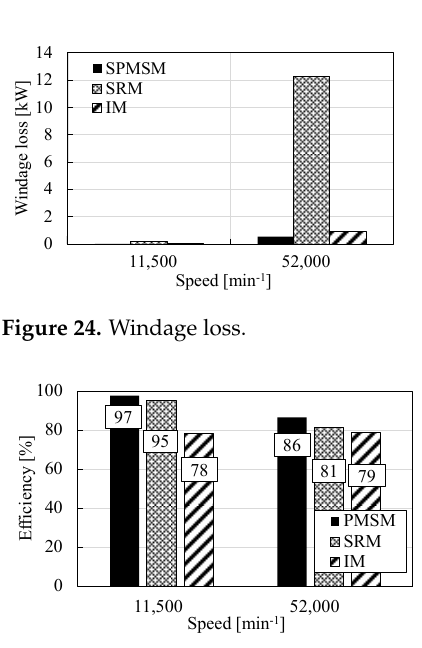
Figure 25. Motor efficiency.